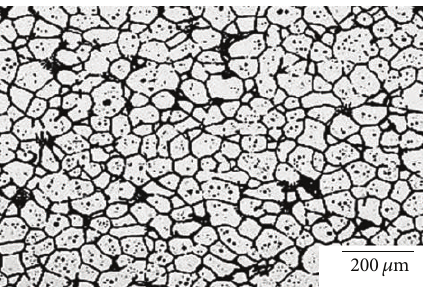
Figure 33: Microstructure of as-supplied M2 tool steel obtained by the DPRM